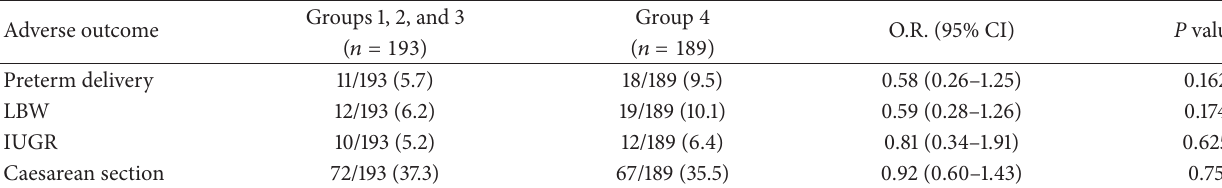
Table 4: Logistic regression analysis of adverse outcomes among anemic women and women with depleted iron stores (Groups 1, 2, and 3) versus nonanemic women (Group